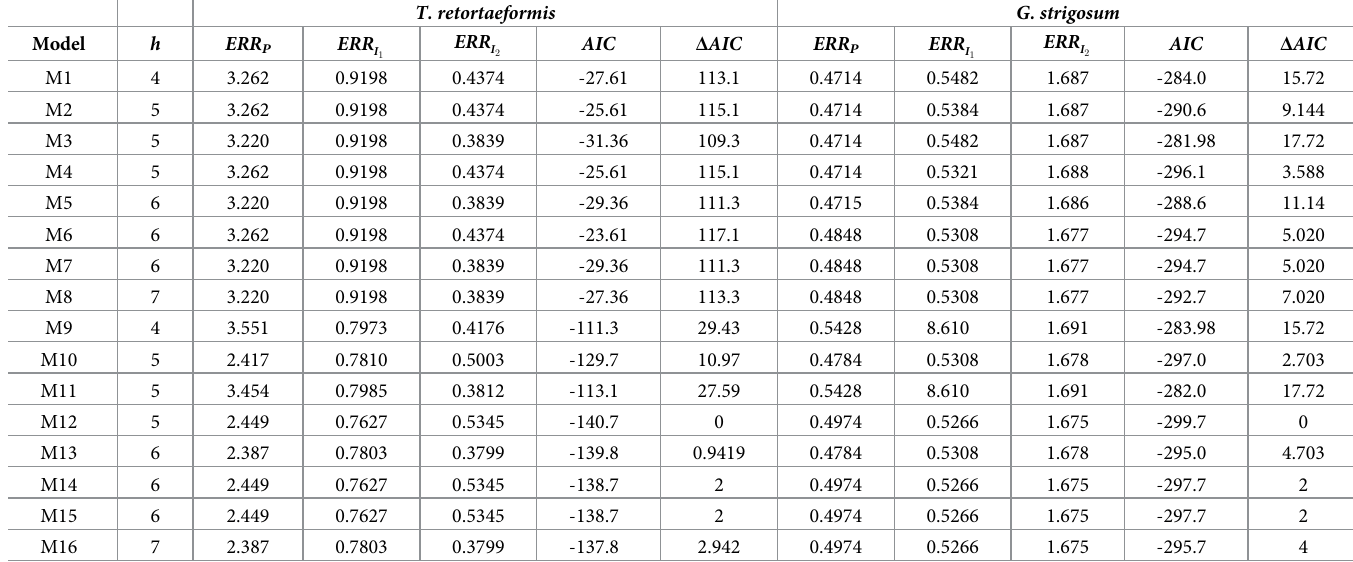
Table 5. Summary of competing models for single infections based on performance and level of complexity. Model complexity, h , the contribution of each variable to the error function ( ERR P , ERR and ERR ; see Eq 3), AIC and Δ AIC are reported for both T. retortaeformis and G. strigosum . I 1 I 2